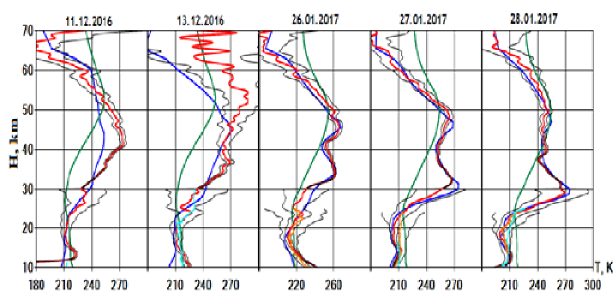
Fig. 5. Vertical temperature distribution on separate nights